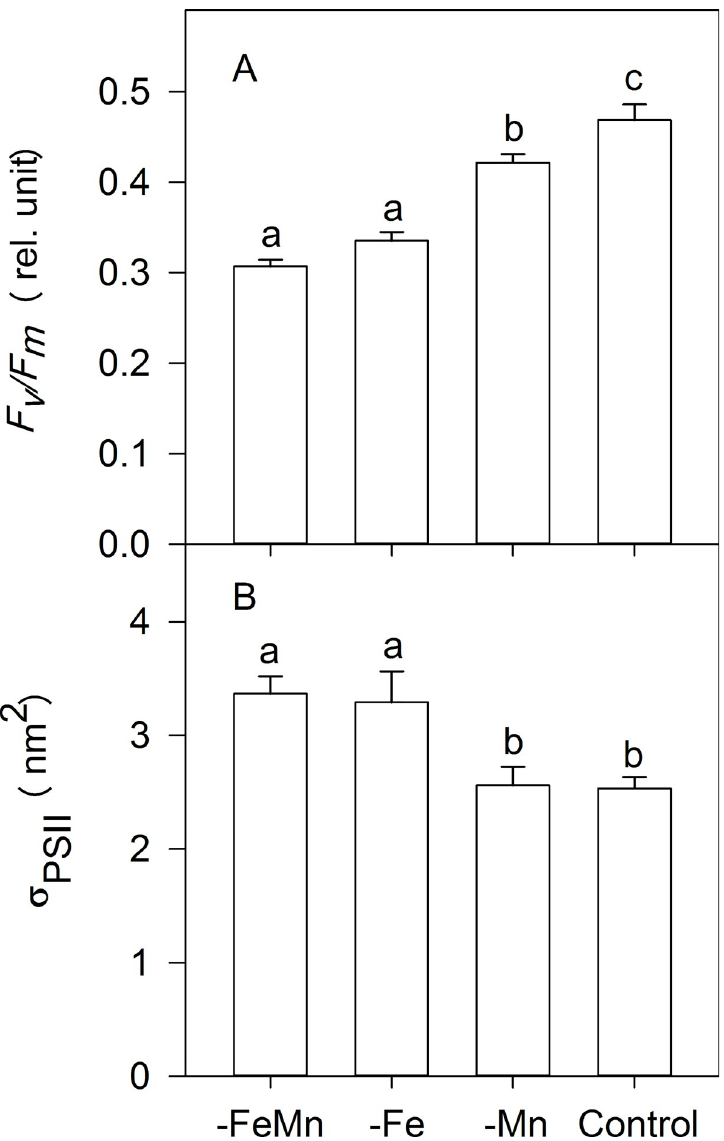
Fig 1. The dark-acclimated maximum PSII quantum yield F (A) and the dark-adapted functional absorption v /F m cross section of PSII photochemistry σ PSII (B) of C . debilis grown in naturally FeMn-poor Antarctic seawater (-FeMn) and to which additions of either Mn alone (-Fe), Fe alone (-Mn) or both (control) were given. Values represent the means ± SD (n = 3). Different letters indicate significant differences between treatments ( p < 0.05).